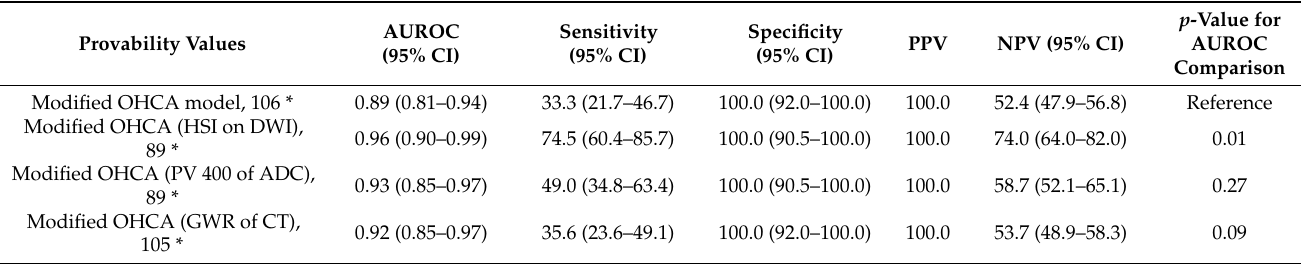
Table 3. A comparison of prognostic performance using the modified OHCA (out-of-hospital cardiac arrest) and CAHP (cardiac arrest hospital prognosis)